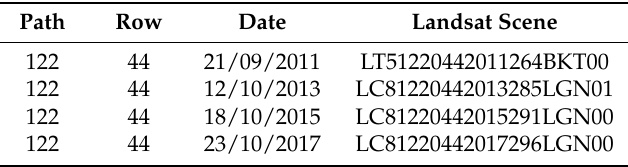
Table A1. List of Landsat images used in this